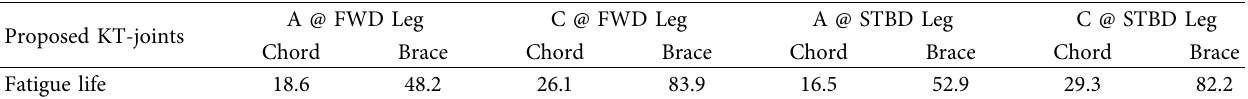
Table 8: Fatigue life (years) at the concerned crown points of the proposed KT-joints. Proposed KT-joints